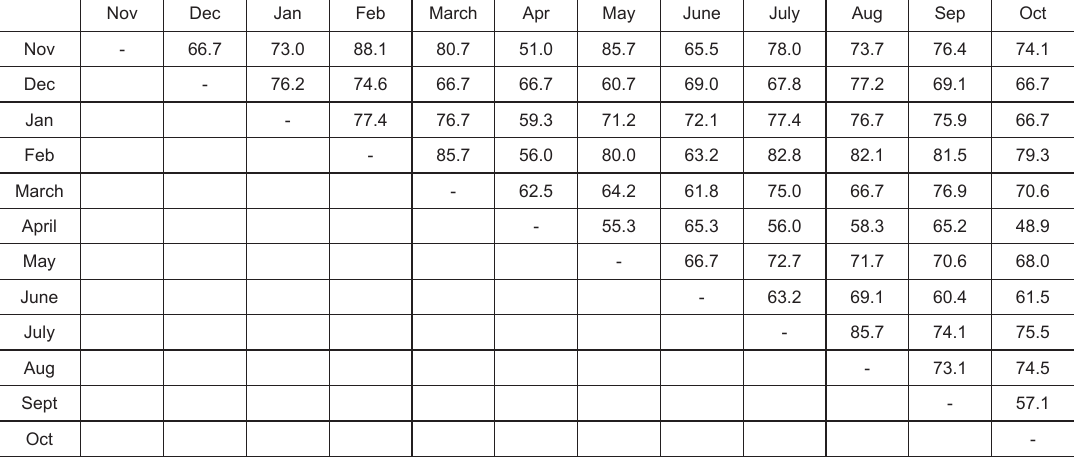
Table 4. Rotifera community similarities of Deepor Beel (Station II)